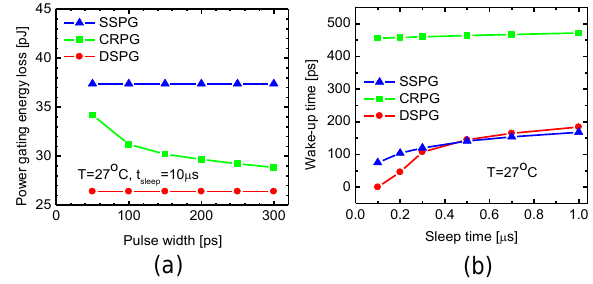
Figure. 5. (a) Power gating energy loss vice versa pulse width of the TGN using the 45-nm PTM, V =1.1 V, W /W =10%, and t =10µs. DD PG Logic sleep